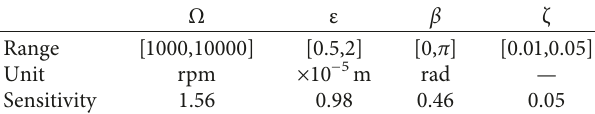
Table 1: The concerned parameters and their global